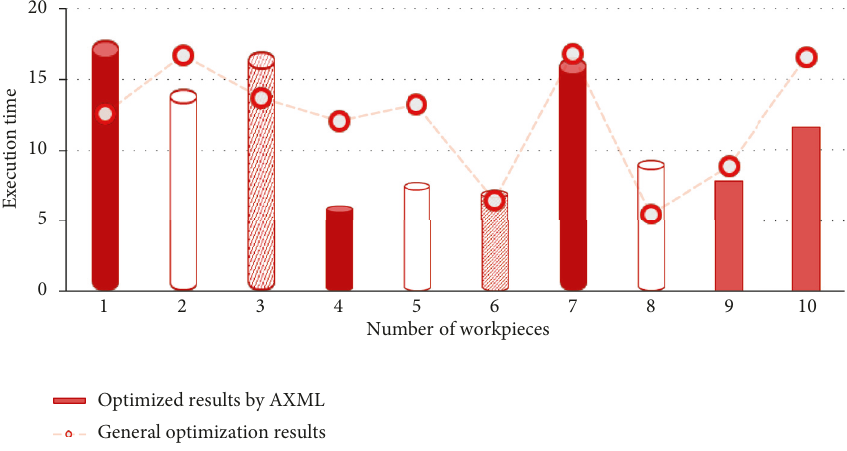
Figure 8: The impact of increased production efficiency on optimization